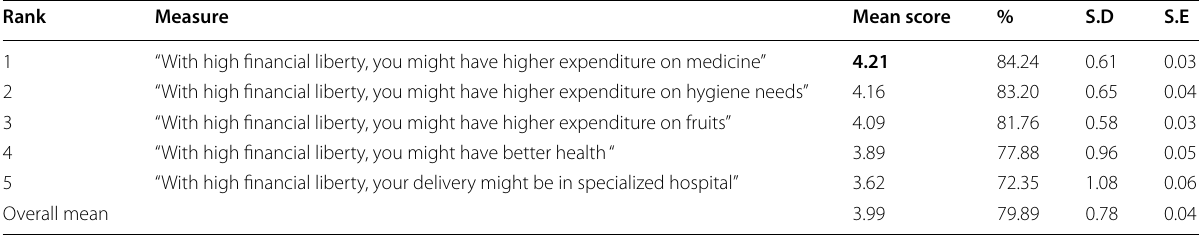
Table 6 Rank analysis of impact of economic violence on health of Muslim women Rank